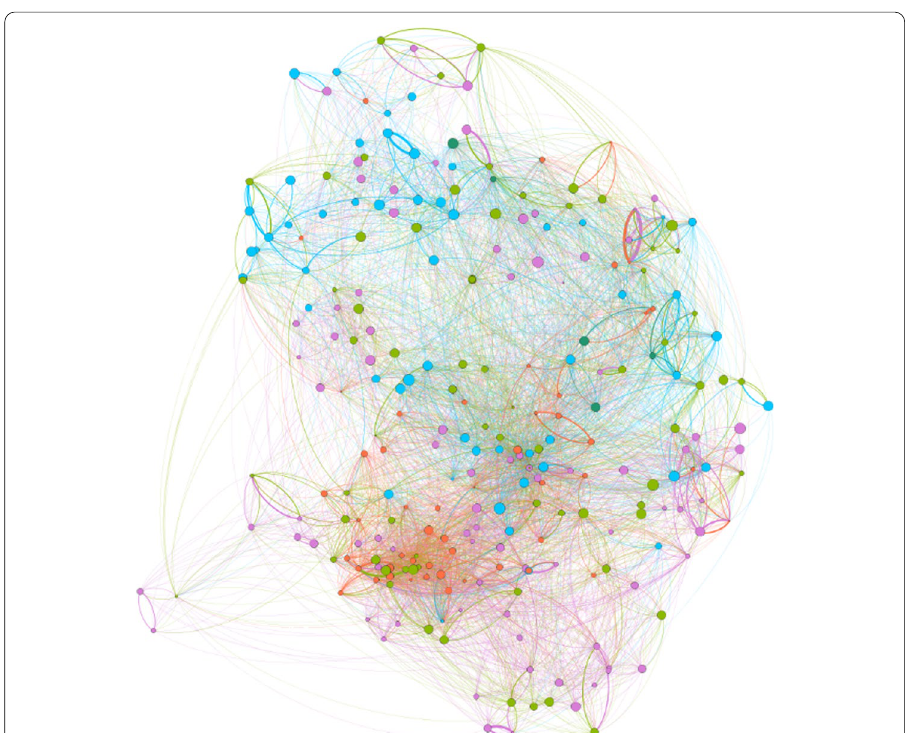
Fig. 2 The French Occupation Space. This graph has been realized with Gephi software using OpenOrd algorithm (Martin et al. 2011). The nodes’ sizes are proportional to their outward centrality, and their color correspond to PCS-1digit communities classes. Edges’ sizes are proportional to their weights. Only top 50% of existing edges were